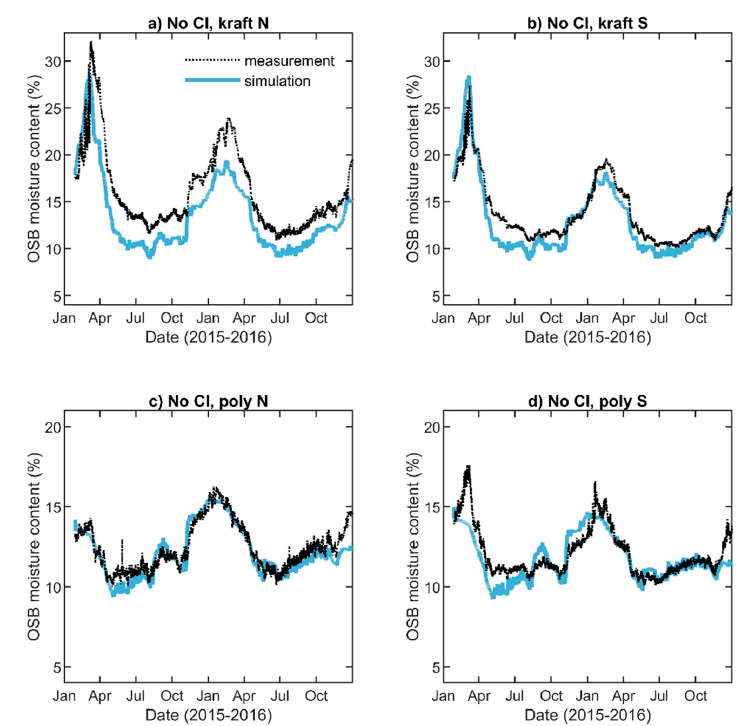
Figure 14. Measured and simulated moisture content of OSB for walls with no exterior insulation.